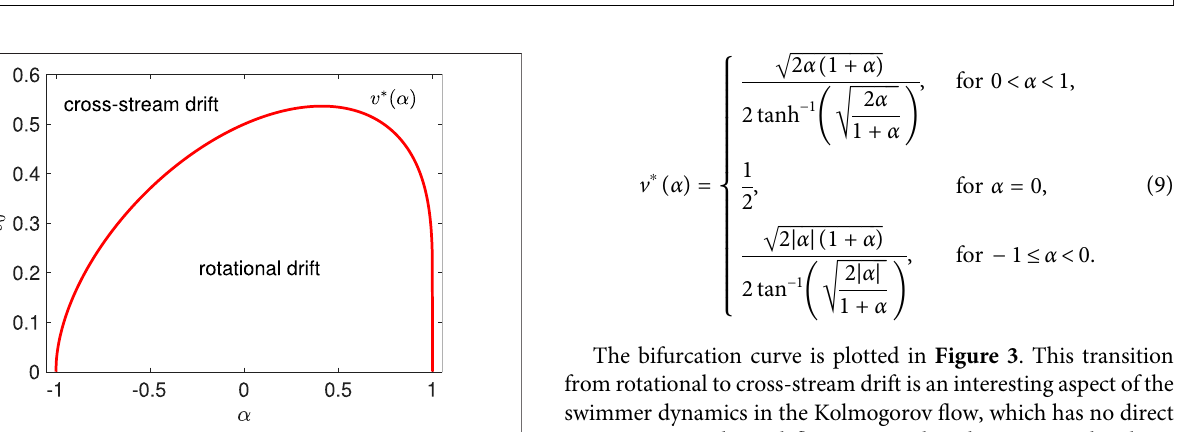
rotation, but oscillates around θ (cid:1) π /2 or θ (cid:1) 3 π /2, respectively.